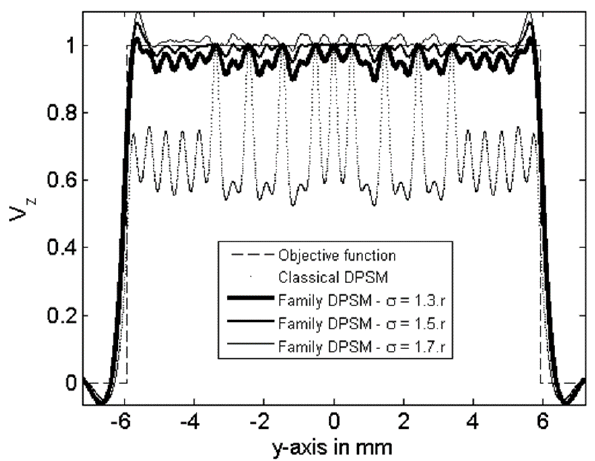
z = 1) than the classical DPSM ‐ generated results. It